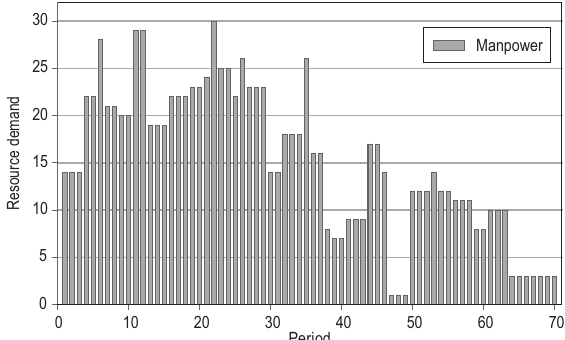
Fig. 5. Project resource profile before resource-leveling process